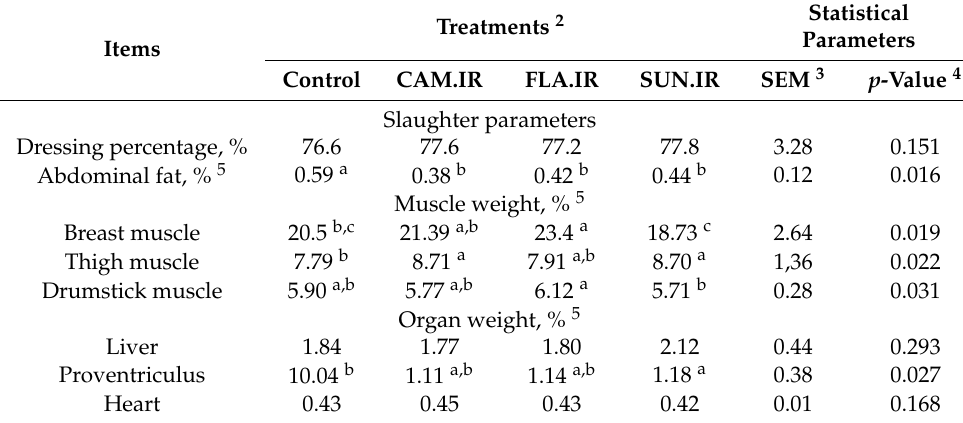
Table 3. Selected productivity parameters and weight of parts of broiler chicken carcasses 1 .